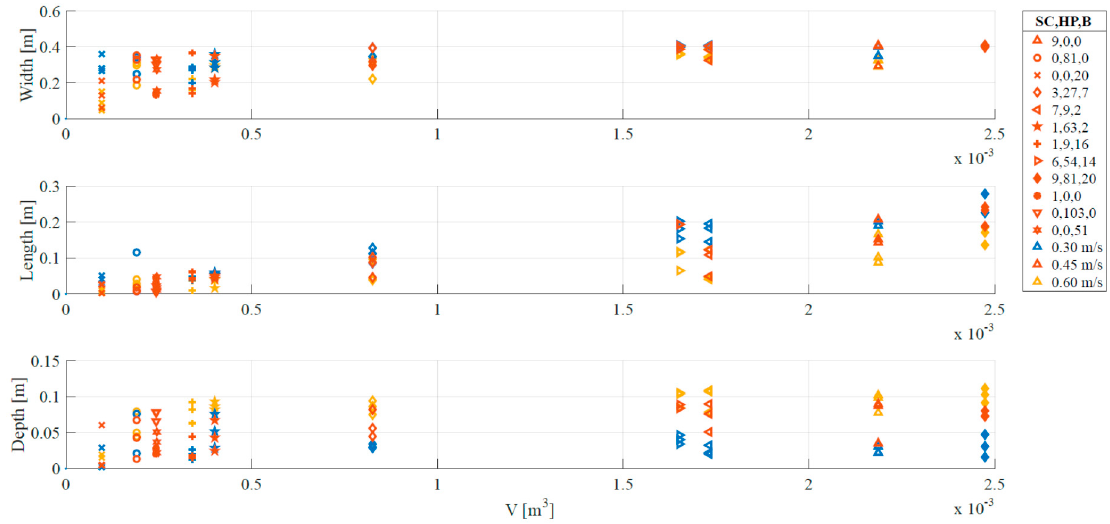
Figure 11. Debris dam properties: ( a ) width (y-direction); ( b ) length (x-direction); and ( c ) depth (z-direction) as a function of the debris volume. The debris configuration is indicated with differing symbols; the flow velocity is also displayed.